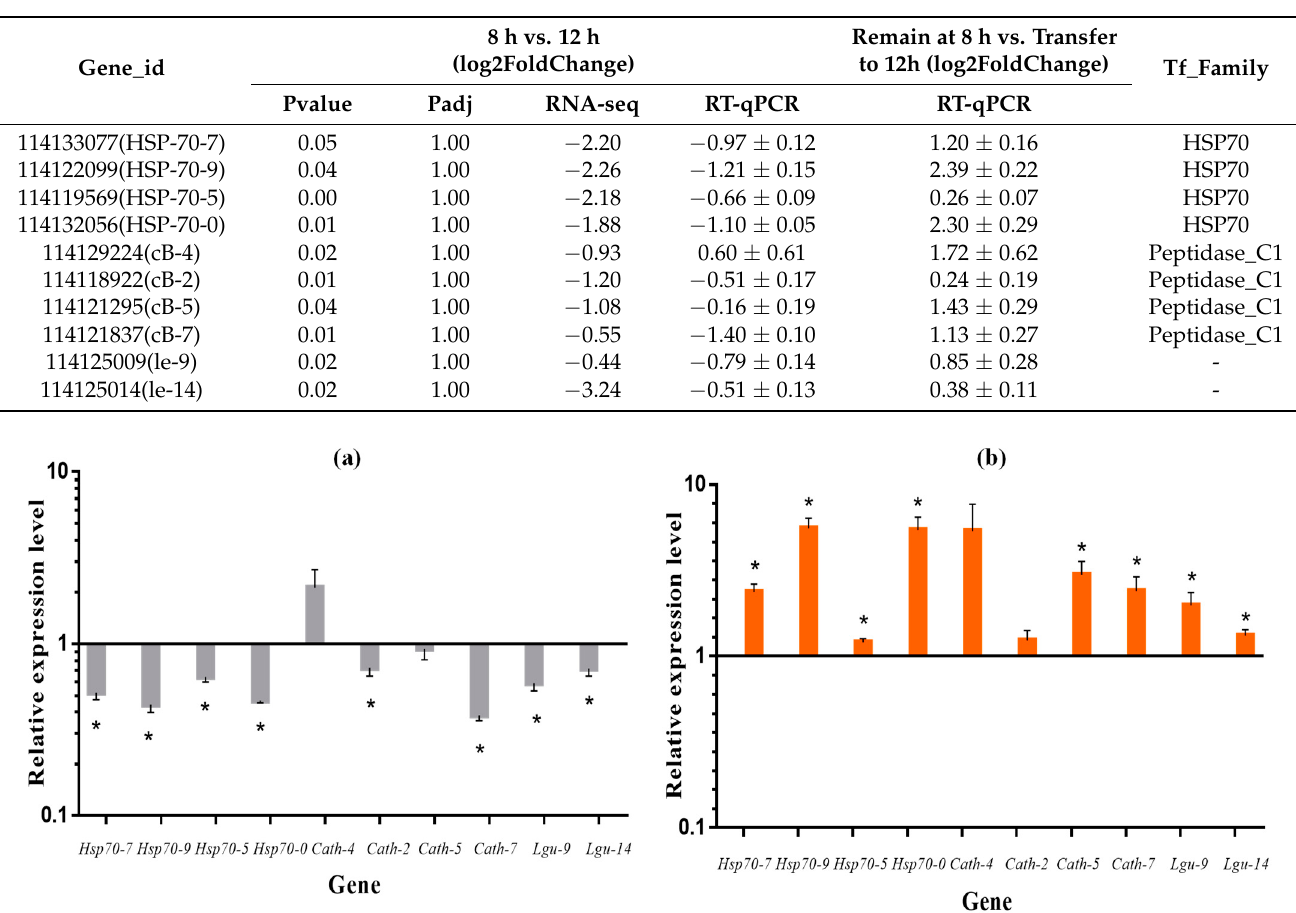
Table 2. The relative expression levels of candidate genes of the fifth generation Aphis gossypii under 8:16 vs. 12:12 light–dark cycles; and Aphis gossypii under continuous 8:16 vs. transfer from 8:16 to 12:12 light–dark.